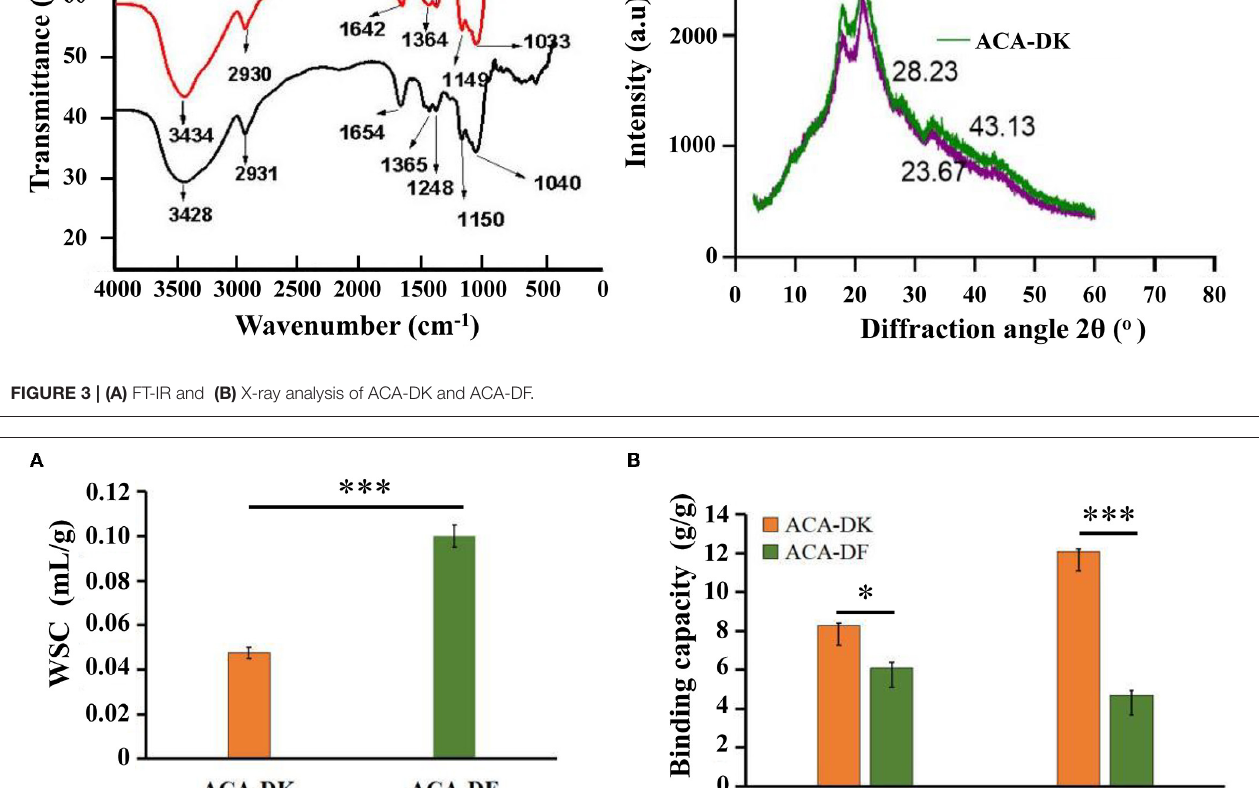
RAW 264.7 macrophages after 24 h of cultured ( P < 0.05).